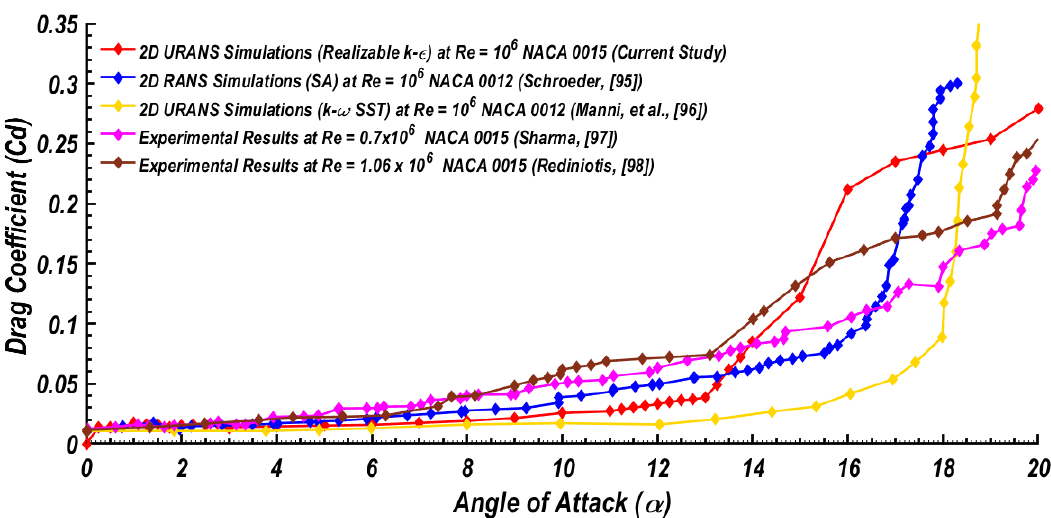
Figure 5. Comparison of airfoil average drag coefficient against the angle of attack at chord Re = 10 6 (No-control case) with the experimental data and earlier numerical results.